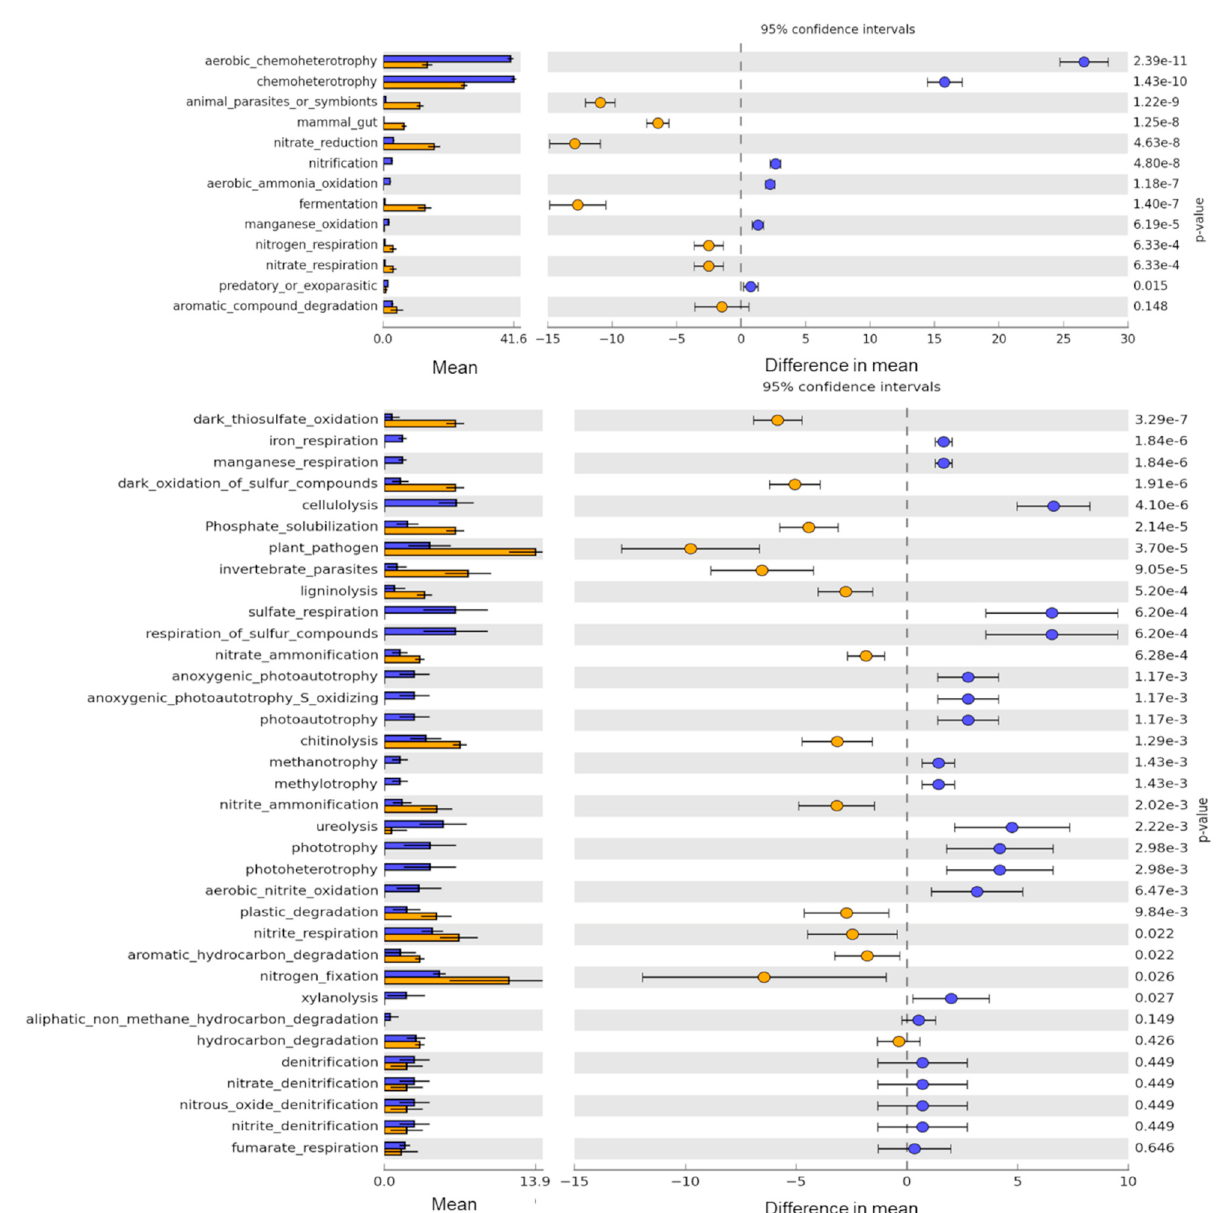
Figure 5. Bacterial associated functions predicted by FAPROTAX. Extended error bar plot indicates significant differences between mean number of bacterial OTUs that potentially performed each function in eDNA (blue) and cultured (orange) samples. Functions overrepresented in the eDNA samples have a positive difference between number of OTUs and functions overrepresented in the culture samples have a negative difference between number of OTUs. Upper section represents functions with average number of OTUs higher than 10 OTUs, whereas the lower section represents functions with those lower than 10 OTUs. p -values based on t -test are shown at